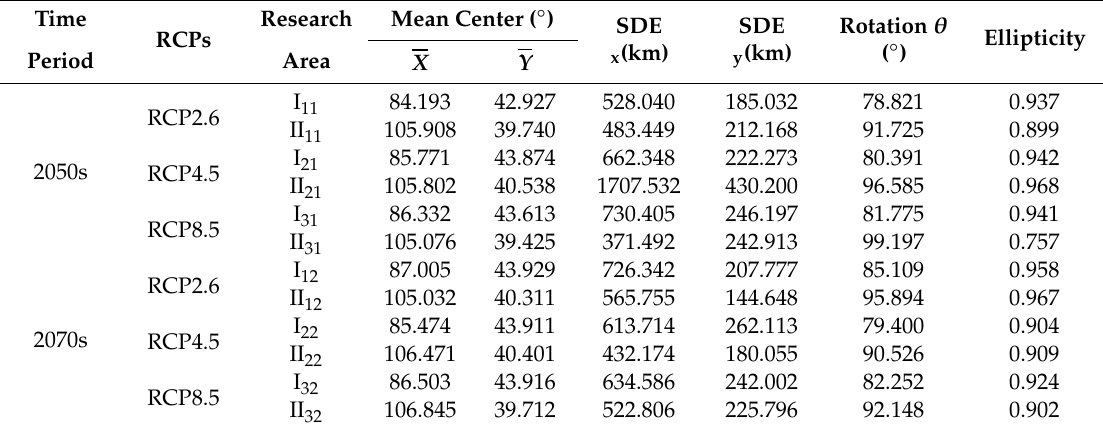
SDE Rotation θ Ellipticity ( ◦ ) x (km) y (km)